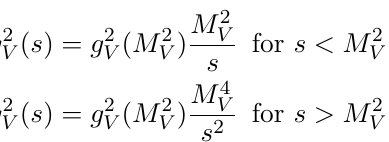
Figure 6 . Predictions of g cussed in the text. The benchmark points speci(cid:12)ed with geometric symbols correspond respectively to those in (cid:12)gure